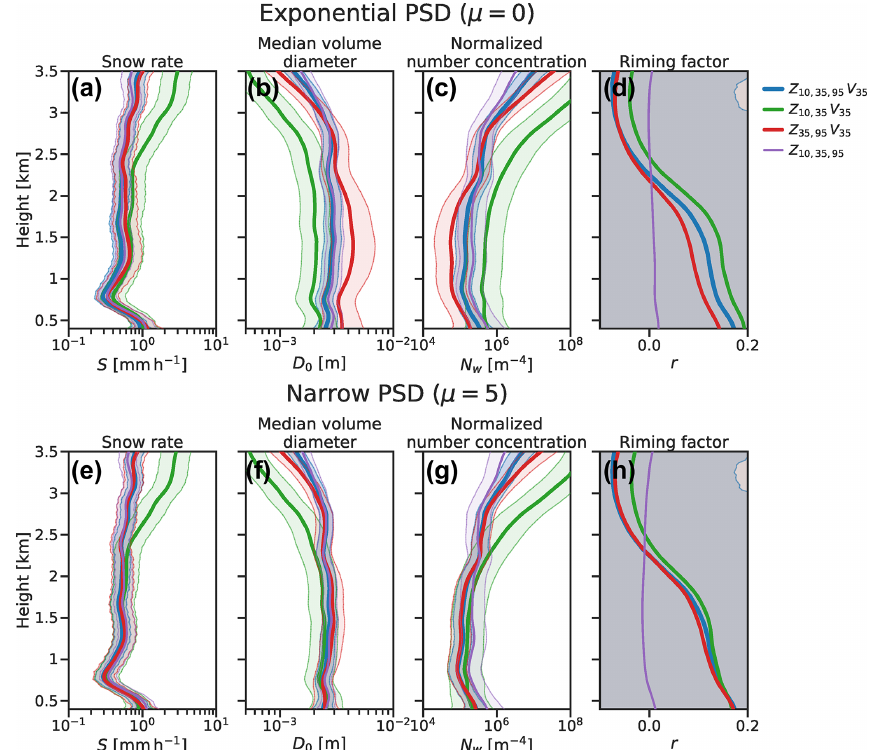
Figure A1. Profiles of retrieved variables for retrievals of a selected profile during the rimed snow regime. Retrievals assuming (a–d) an exponential PSD are compared against those with (e–h) a narrow PSD with µ =